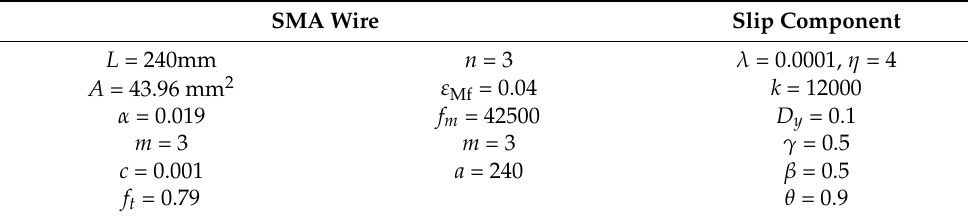
Table 6. Determined the parameters of the SMA wire and slip